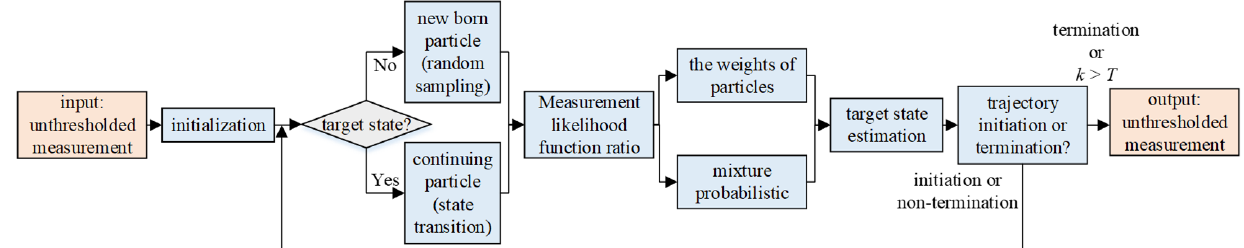
Figure 3. Iteration steps.